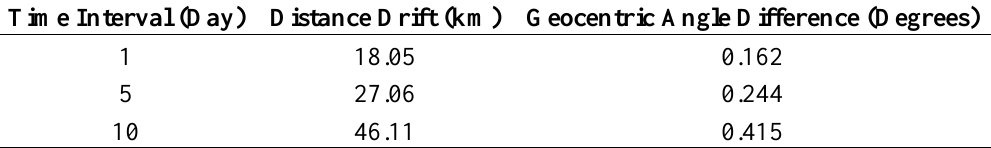
Table 2. Analysis of the perigee nadir-point drifts in GEO